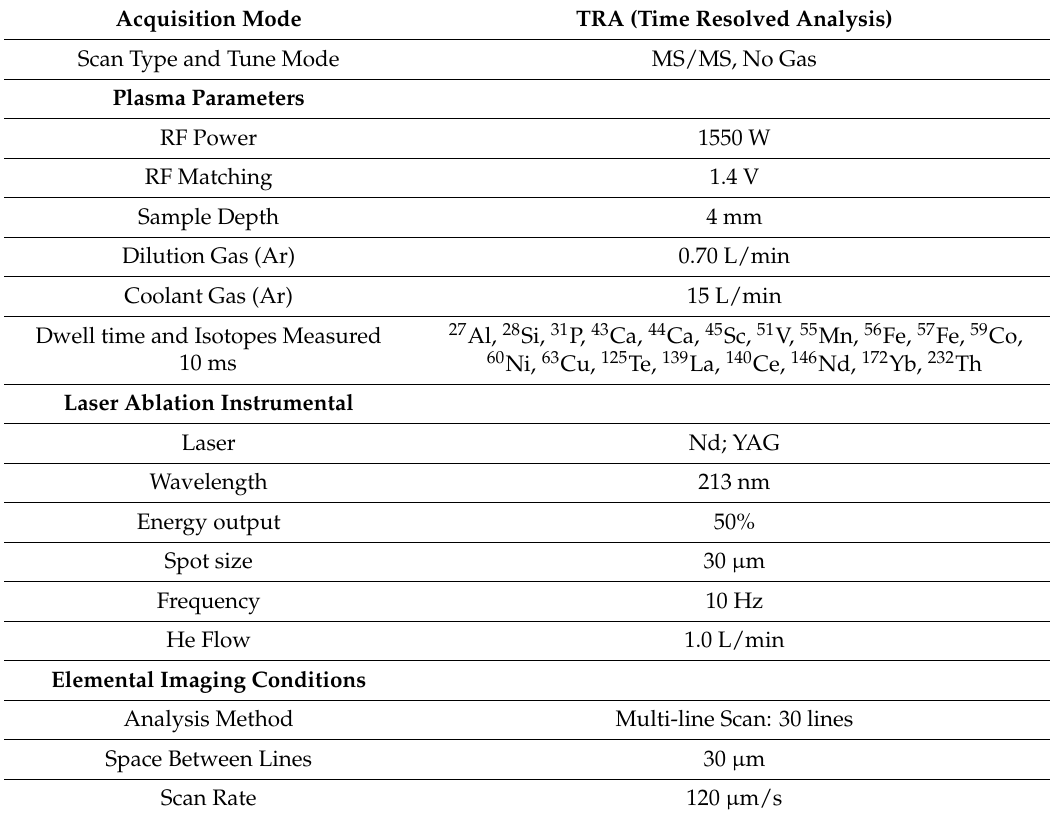
Table 1. 8800 ICP-MS QQQ instrument conditions for laser ablation inductively coupled plasma mass spectrometry